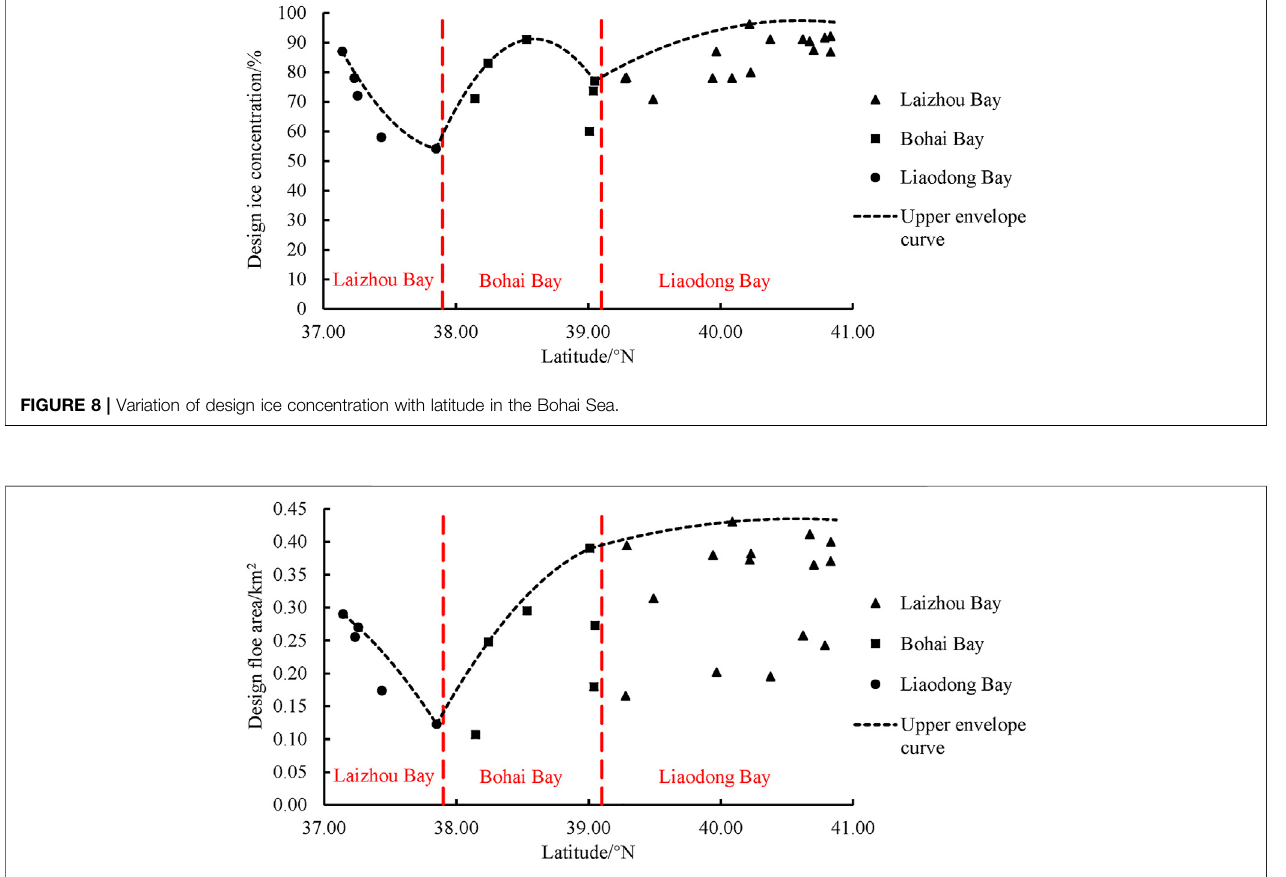
FIGURE 9 | Variation of design fl oe area with latitude in the Bohai